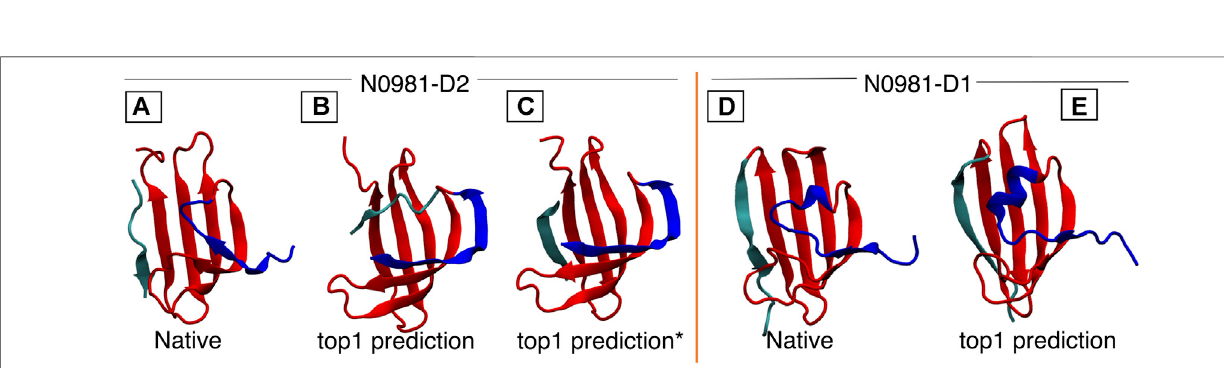
FIGURE 4 | Performance of the top 1 cluster (red) superposed on the native structure (cyan) for each protein and domain. The numbers below the target name represent the C α RMSD (Å) and GDT-TS values.